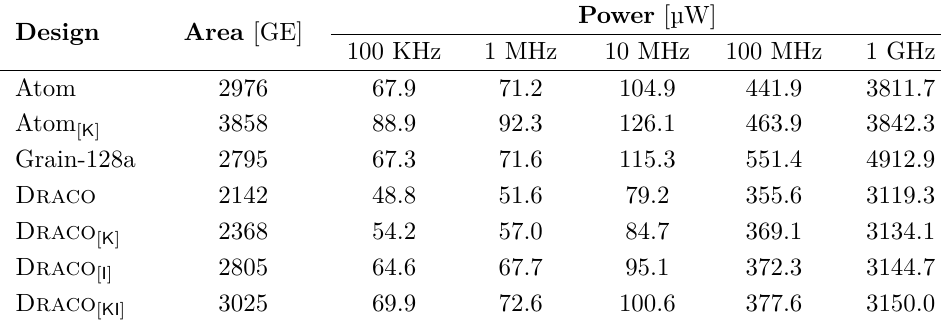
Table 2: Hardware metrics for Draco and